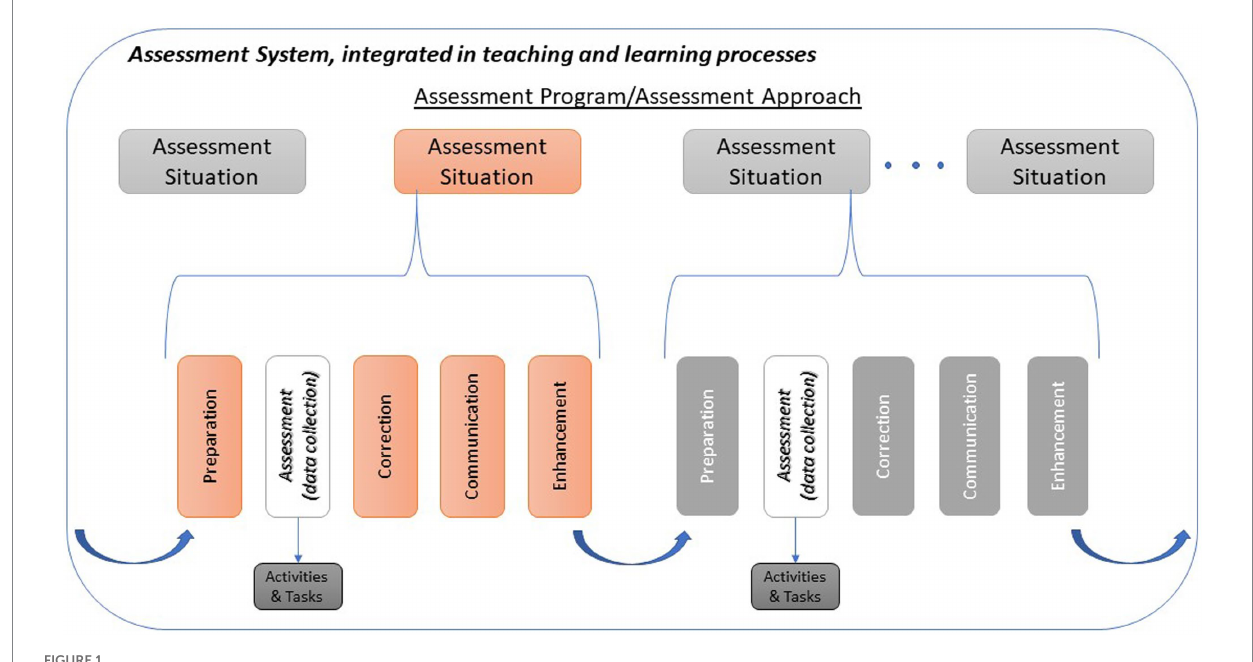
FIGURE 1 Multidimensional Model of Classroom Assessment Practices (adapted from Coll et al.,